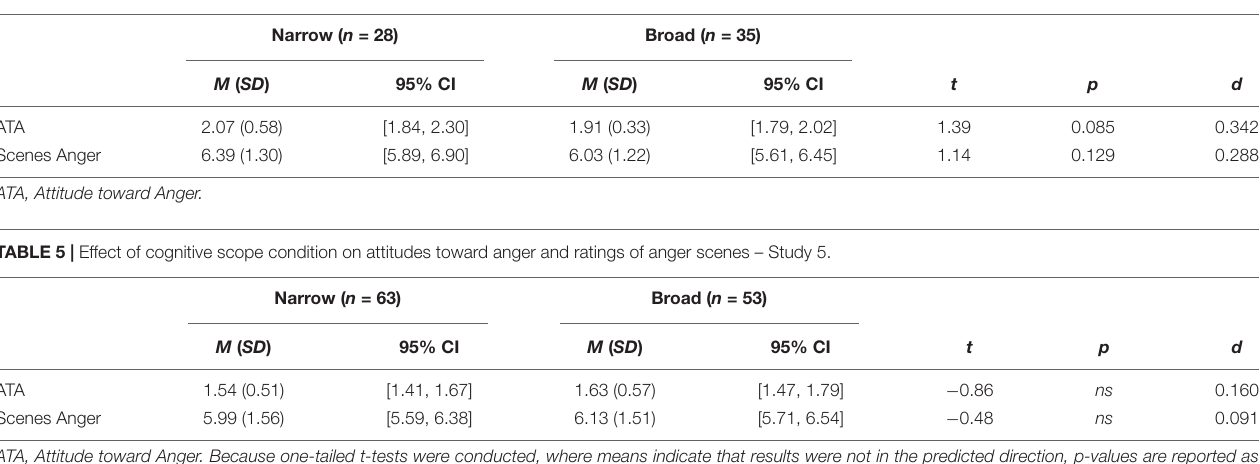
TABLE 4 | Effect of cognitive scope condition on attitudes toward anger and ratings of anger scenes – Study 4.